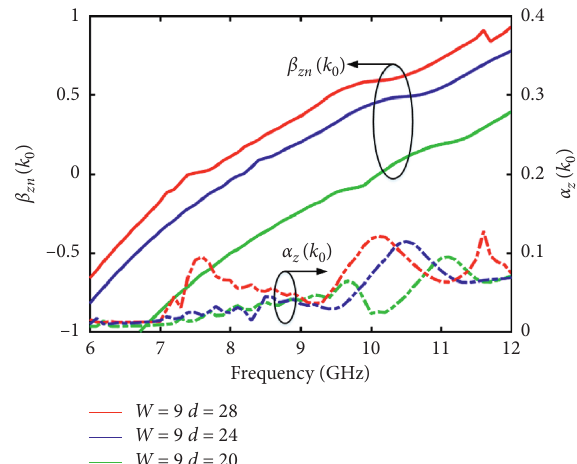
Figure 5: The normalized propagation wavenumbers of the pro- posed periodic antenna with different d ( W � 9 mm).